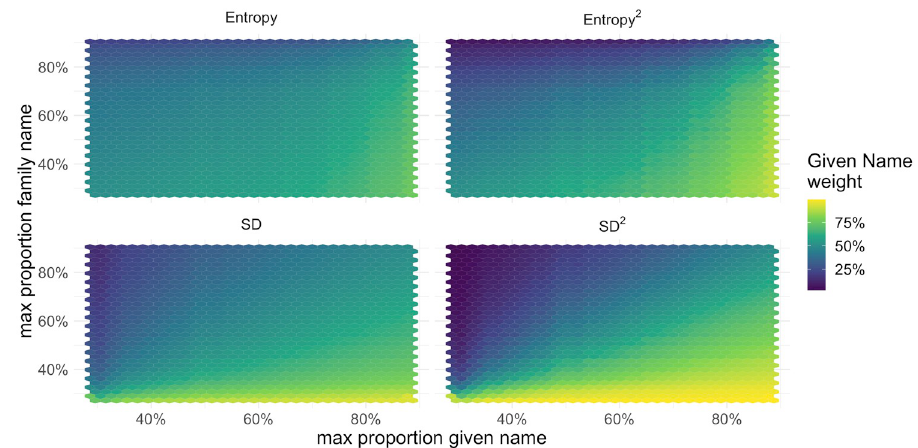
Fig 2. Given names weight distribution by given and family name skewness. Simulated